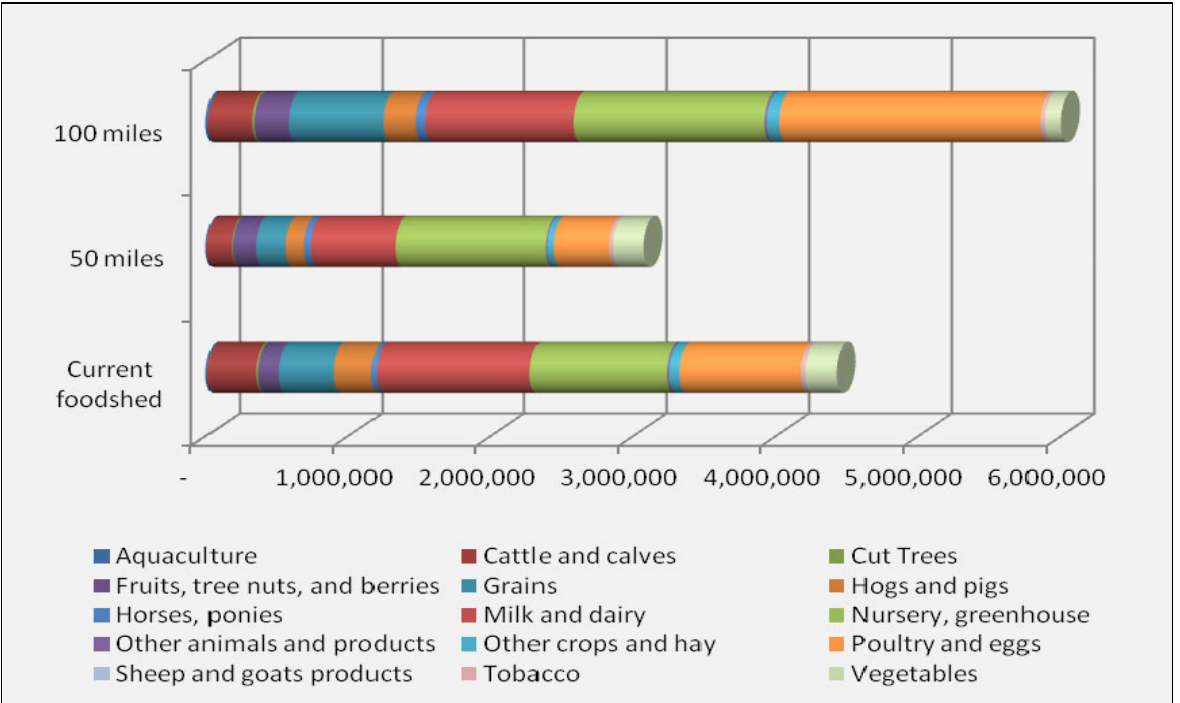
Figure 3. Agricultural Production Sales (in US$1,000) by Region and Product